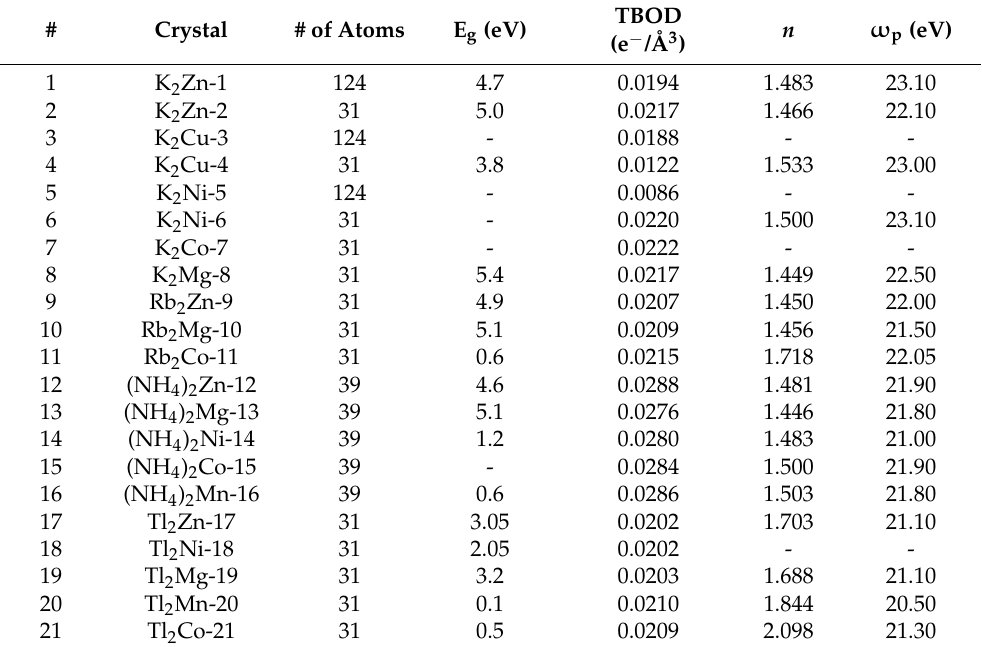
Table 2. Energy band gap (Eg), total bond order density (TBOD), refractive index ( n ), and plasma frequency ( ω p ) for the 21